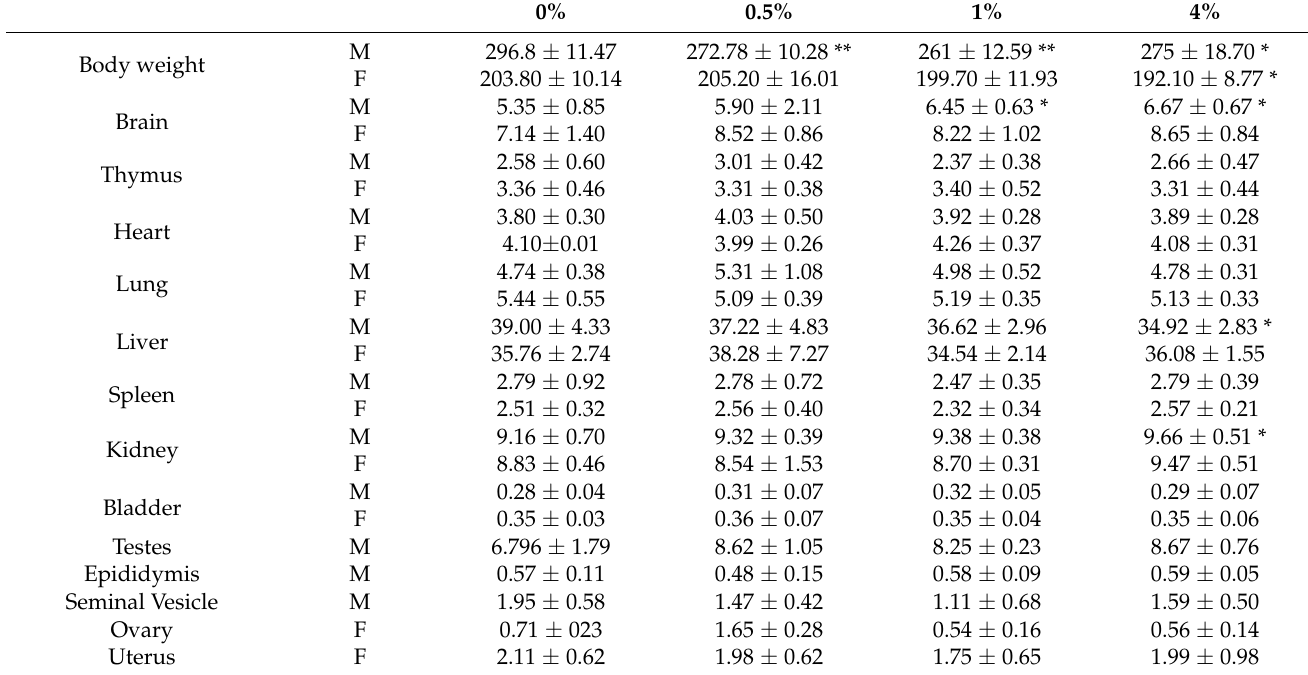
Table 1. Relative organ weights for male